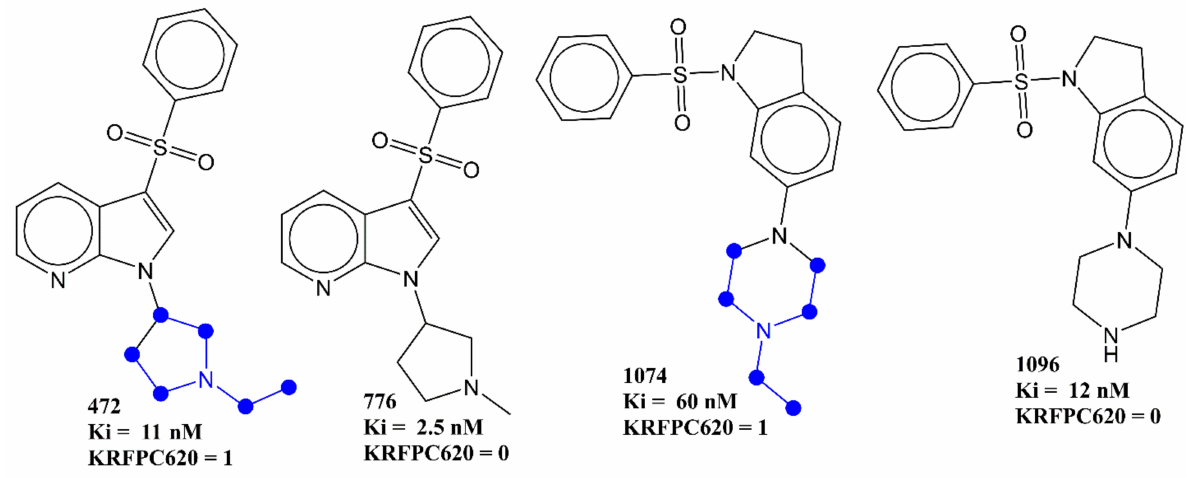
Figure 7. Pictorial representation of KRFPC660 (blue colored) using representative